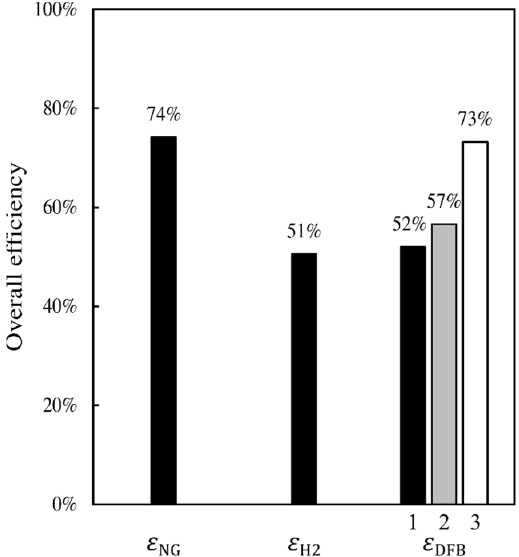
Figure 4. Overall DRI production efficiencies for the NG-DR, H 2 -DR, and DFB-DR routes. The efficiencies are defined in Table 3. Columns 1, 2, and 3 for the efficiency of the DFB refer to ε DFB ,1 , ε DFB ,2 , and ε DFB ,3 , respectively. Table 8. Distribution of carbon in the outputs of the process, in terms of the fraction of the total carbon input, which accounts for the carbon in the biomass, the scrubbing agent (RME in the calculations), and the CO 2 from the flux agent, which is assumed to be CaCO 3 in the calculations. The production yields of the outputs are also shown in kg/t liquid